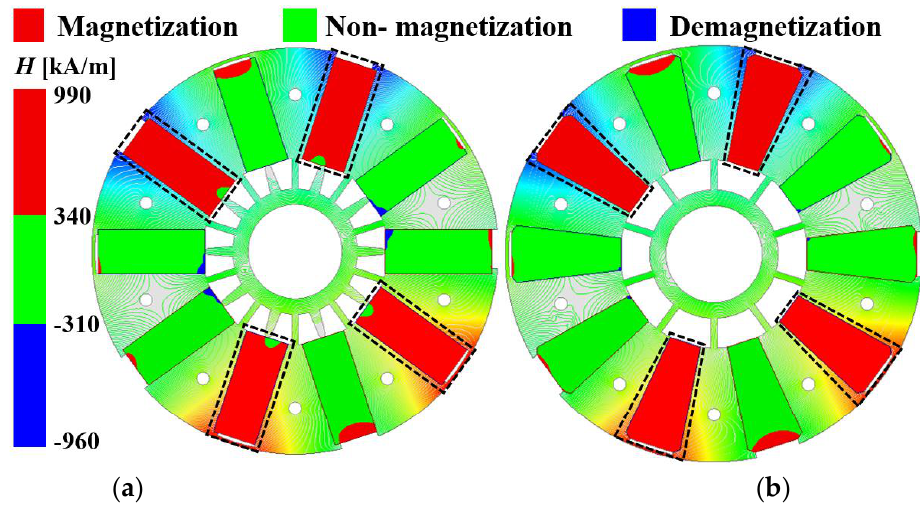
Figure 8. Comparison of magnetization analysis results. ( a ) conventional model, ( b ) proposed model. Four of the ten magnets are magnetized based on a three-time divided magnetization. The specimens to be magnetized are indicated by dotted black lines. The color bar on the left side of Figure 8 indicates the magnitude of the magnetic field, and divides it into magnetized, non-magnetized, and demagnetized regions based on the initial magnetization curve at room temperature and the B − H curve characteristics of the ferrite magnet used